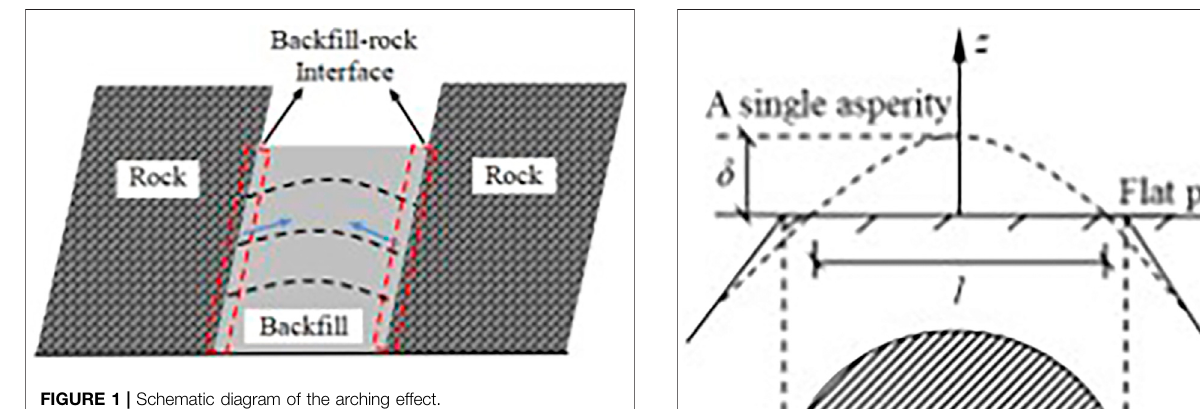
FIGURE 1 | Schematic diagram of the arching effect.